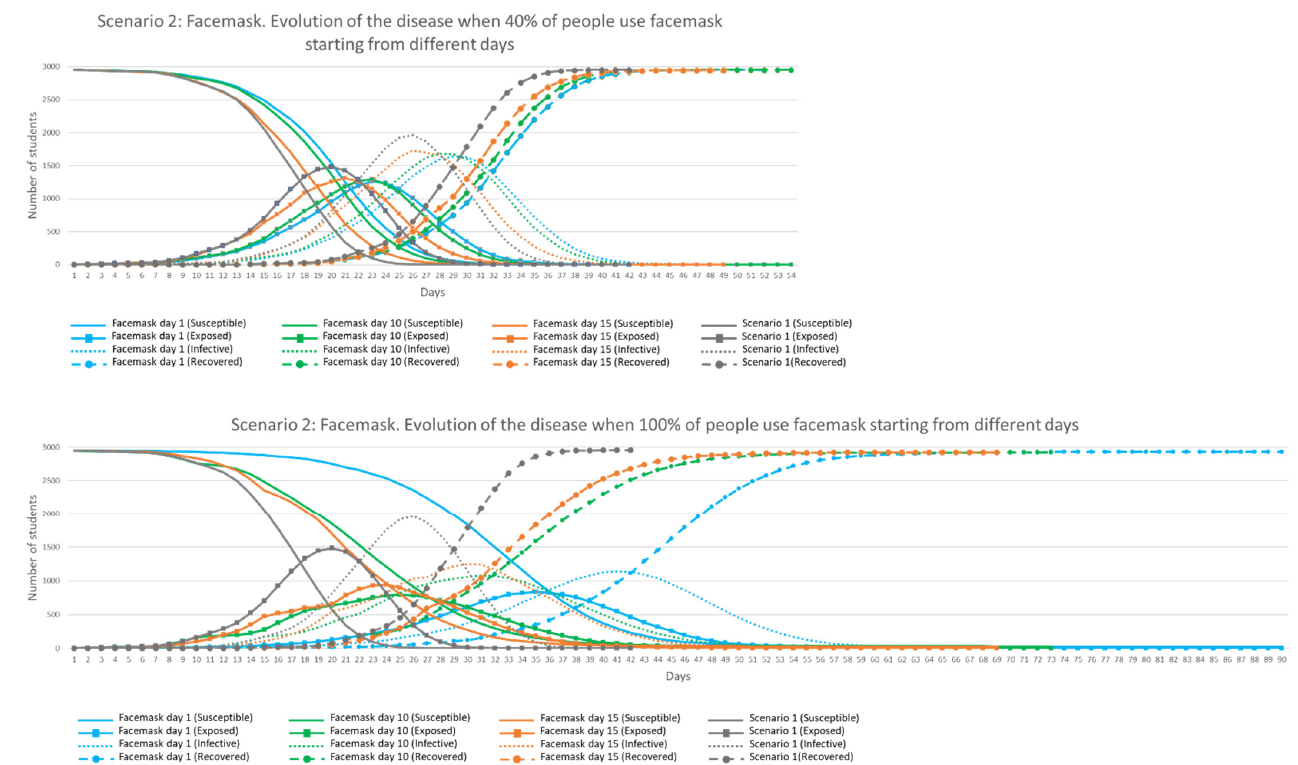
Figure 15. Evolution of the disease for Scenario 2 ‘facemask use’ when 40% (top) and 100% (bottom) of agents use facemasks on different days. Full results for this scenario are included in Appendix F.